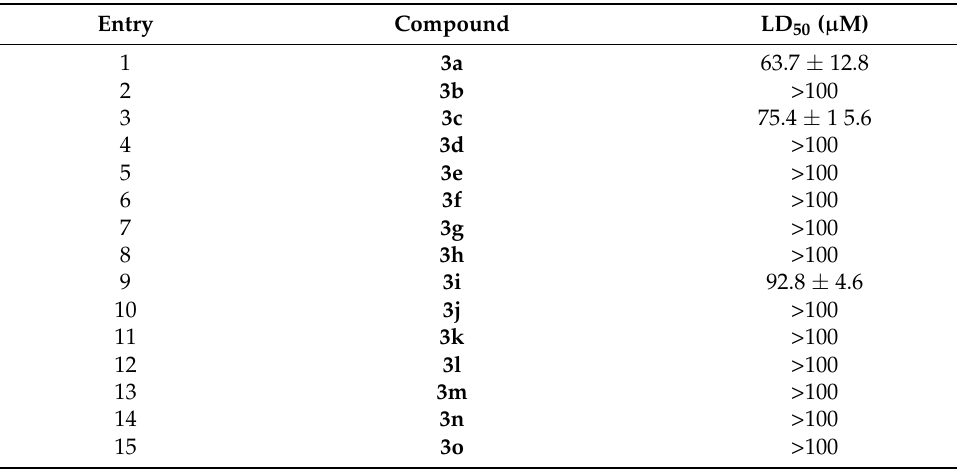
Table 4. Toxicity of compounds 3 in neuroblastoma SHSY5Y